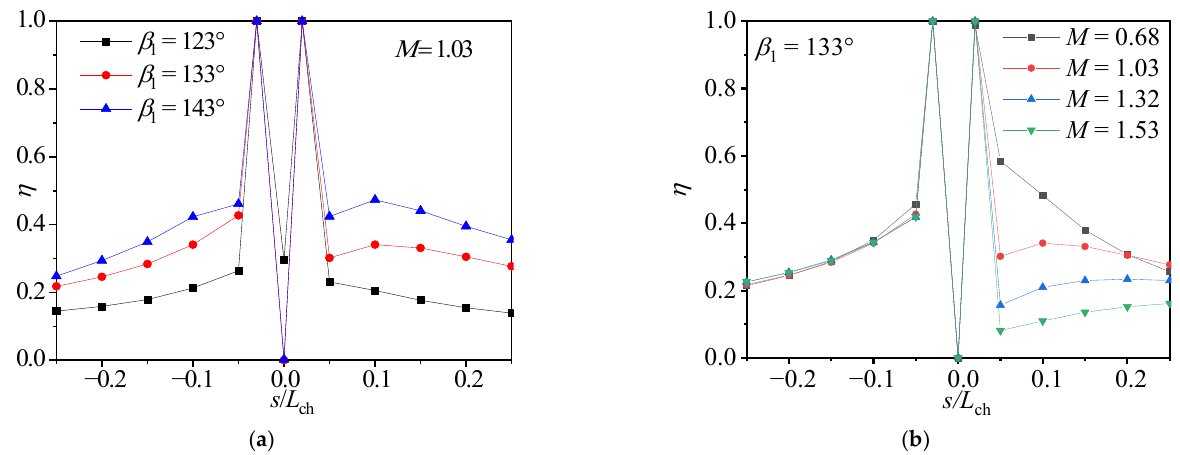
Figure 6. Variation of centerline film cooling effectiveness. ( a ) different inlet flow angles, ( b ) different blowing ratios.